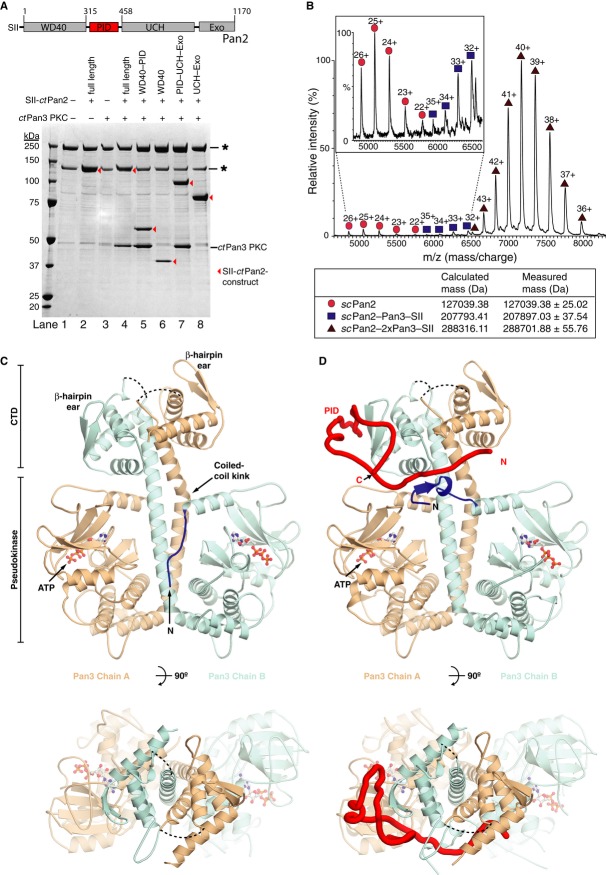
The Pan2–Pan3 complex forms a heterotrimerA ctPan3 interacts with the linker region (Pan3 interacting domain, PID) of ctPan2. Various truncations of StrepII (SII)-tagged ctPan2 (full length, 1–1170; WD40-PID, 1–458; WD40, 1–315; PID-UCH-Exo, 316–1170; UCH-Exo, 459–1170) were co-expressed with ctPan3 pseudokinase/C-terminal domain (PKC, 205–640) in Saccharomyces cerevisiae, and pull-downs were performed using StrepTactin beads. ctPan2 proteins are indicated by a red arrowhead. Asterisks indicate contaminating bands that bind to StrepTactin beads.B Intact Pan2–Pan3 has a stoichiometry of 1:2. NanoESI-MS spectrum of recombinant scPan2-Pan3, showing the major peak series (< 95%) of a heterotrimeric complex of one Pan2 and two Pan3 molecules at 6,500–8,000 m/z (dark red triangles).C, D The ctPan2 linker region wraps around a homodimer of ctPan3. Crystal structures of (C) ctPan3 PKC homodimer and (D) ctPan3 PKC bound to the Pan3 interacting domain (PID) of ctPan2. Pan3 chains A and B are shown in wheat and cyan, respectively, and ctPan2 PID is shown in red. The N-terminal residues of Pan3 chain B that change conformation on Pan2 binding are shown in dark blue. ATP is shown in ball and stick representation. Dashed lines connect loops not visible in the electron density. The two views are related by a rotation of 90° around the horizontal axis.